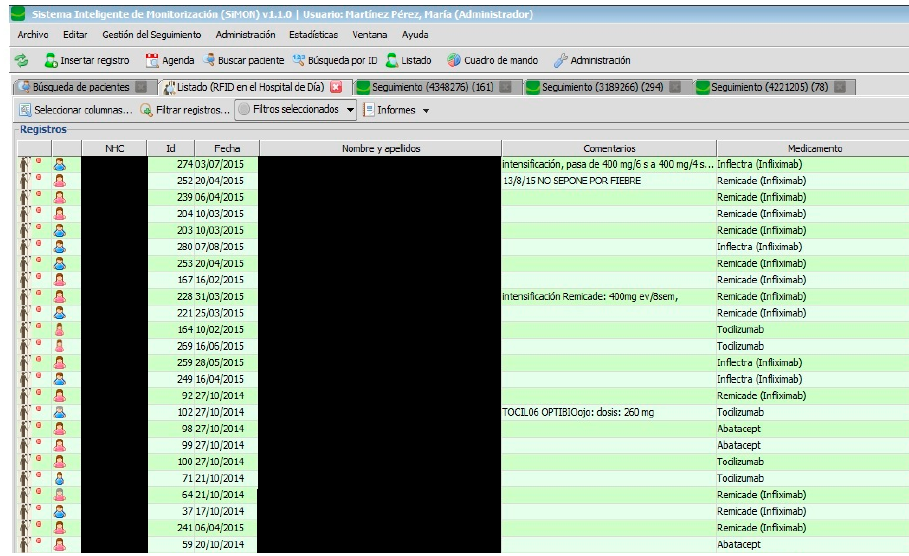
Figure 2. Number of patients.